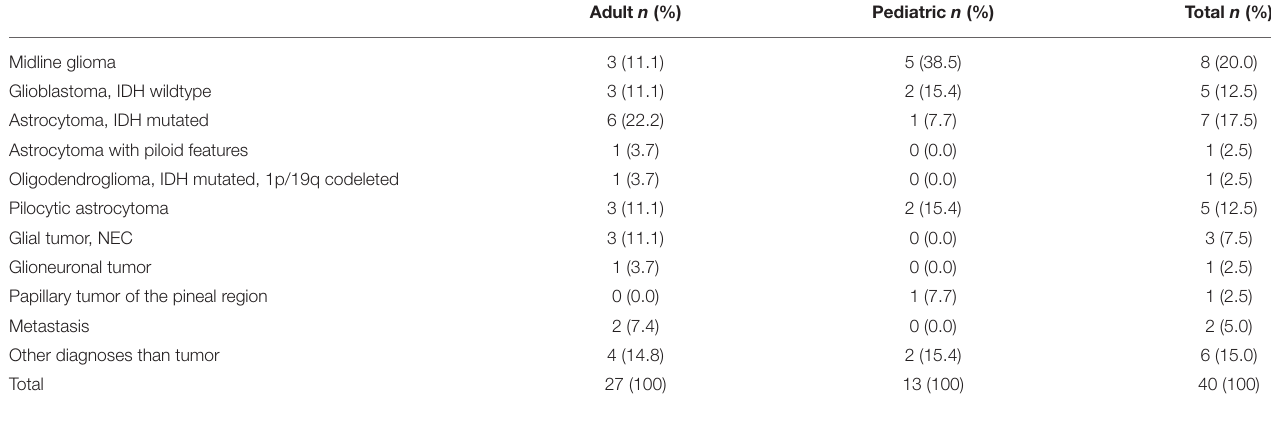
TABLE 5 | Diagnoses of brainstem biopsies in adult and pediatric